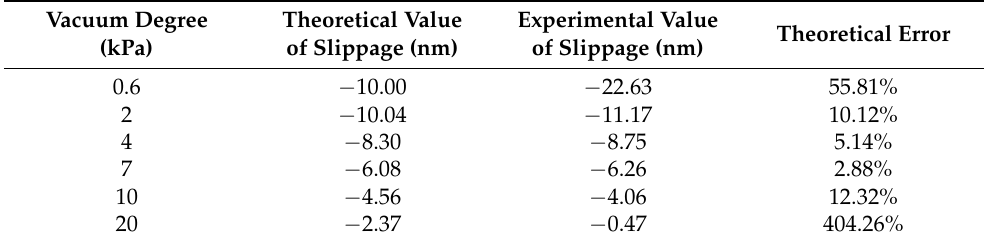
Table 5. Theoretical value, experimental value, and error of slippage (stable acceleration phase to uniform motion